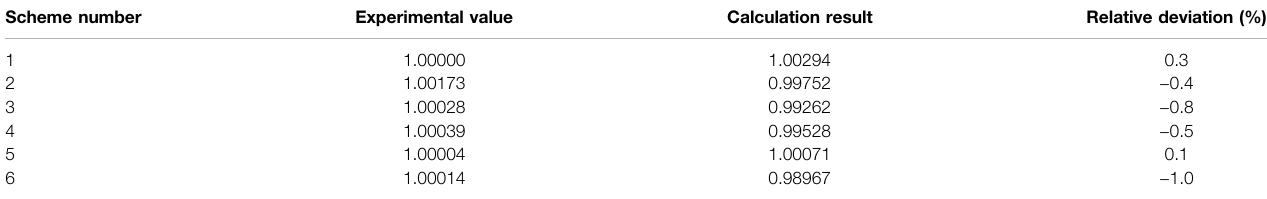
TABLE 2 | k eff veri fi cation calculation results of critical mass measurement test.